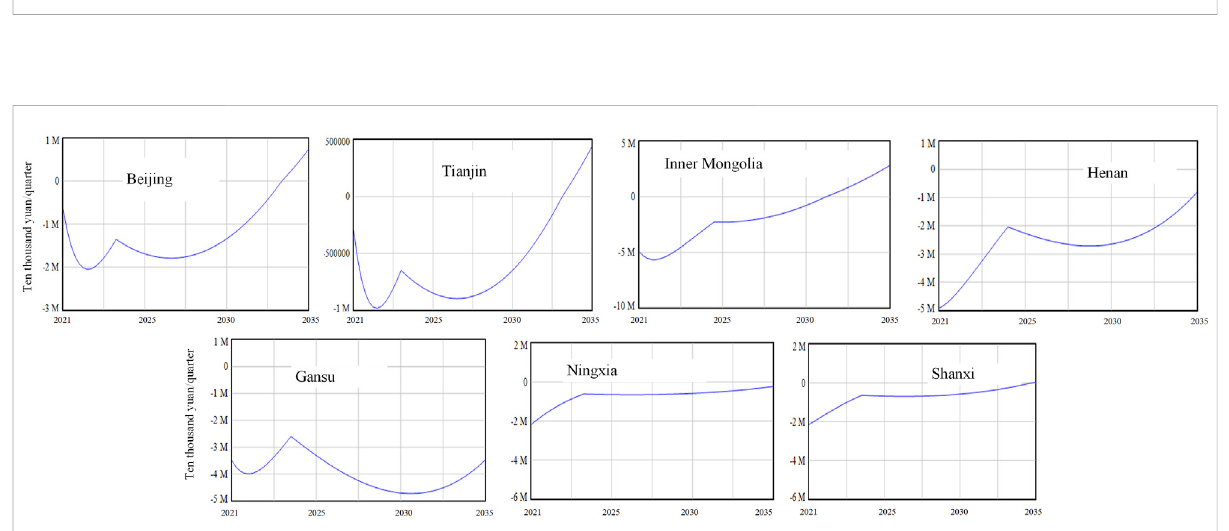
FIGURE 5 BAU scenario of the annual net pro fi t of geothermal heating companies in various provinces and cities in central heating